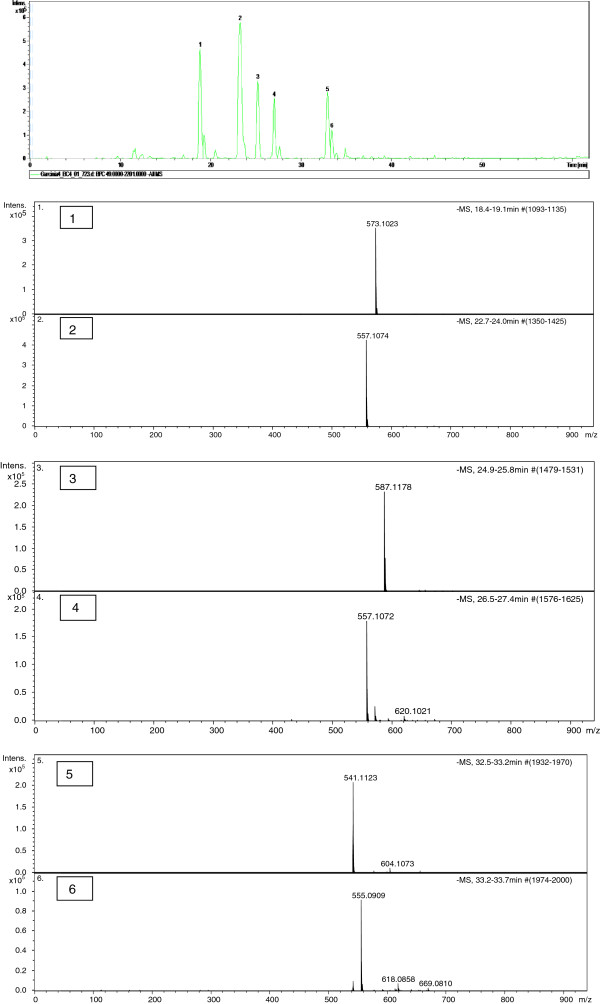
Mass Spectra of kolaviron. (1) Garcinia biflavonoid 2 (C30H22O12, m/z 573.1023); (2) Garcinia biflavonoid 1 (C30H22O11, m/z 557.1074); (3) Kolaflavanone (C31H24O12, m/z 587.1178); (4) Garcinia biflavonoid 1 (C30H22O11, m/z 557.1074); (5) X (C30H22O10, 541.1123), deduced to be binaringenin); (6) Kolaflavone (C30H21O11, m/z 555.0909).